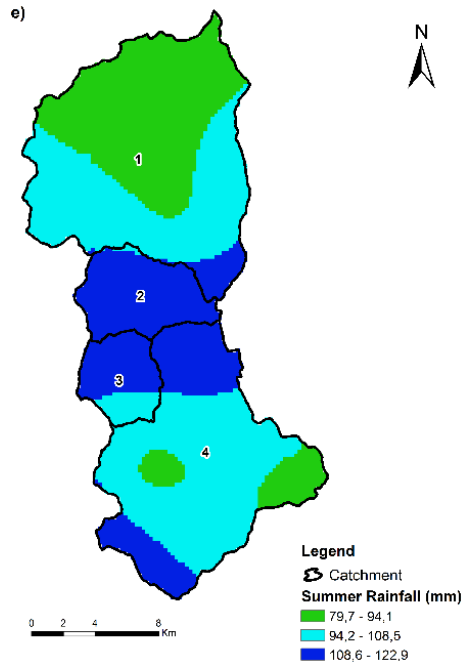
Figure 4. Spatial distribution of ( a ) annual, ( b ) winter, ( c ) autumn, ( d ) spring and ( e ) summer rainfall over the study area.